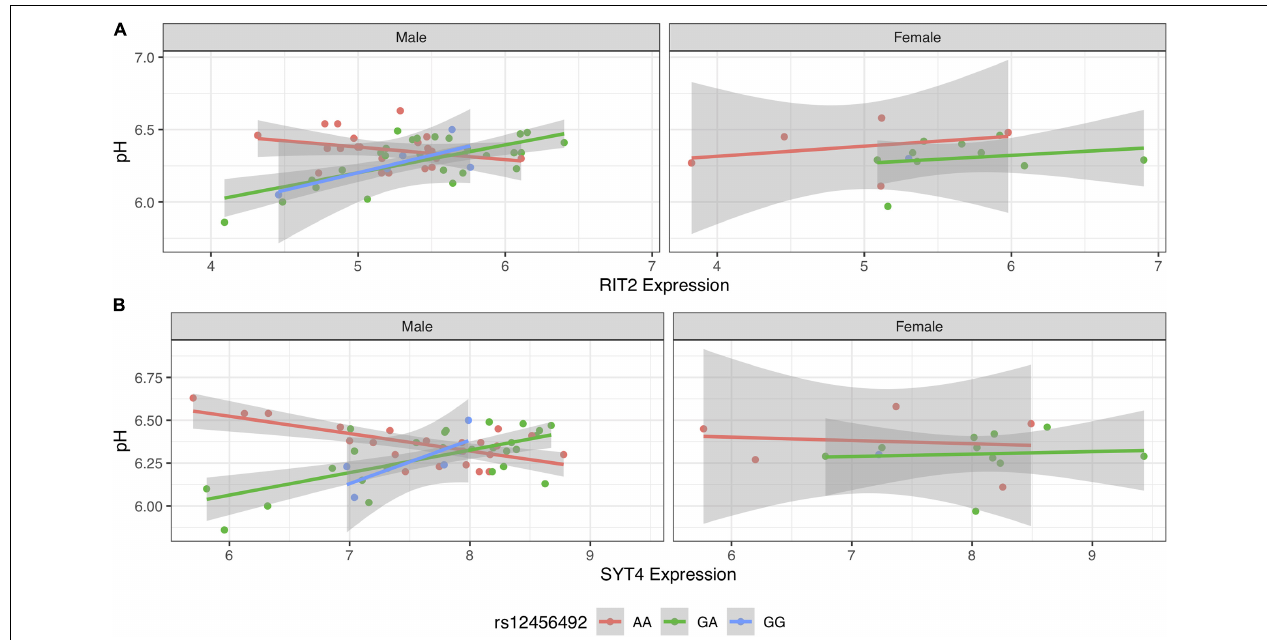
FIGURE 6 | Scatter plot of pH and gene expression grouped by risk SNP genotype and stratified by sex within BrainEAC sample for RIT2 (A) and SYT4 (B) . Genotype groups are colored with lines representing linear fits with shaded areas marking the 0.95 confidence